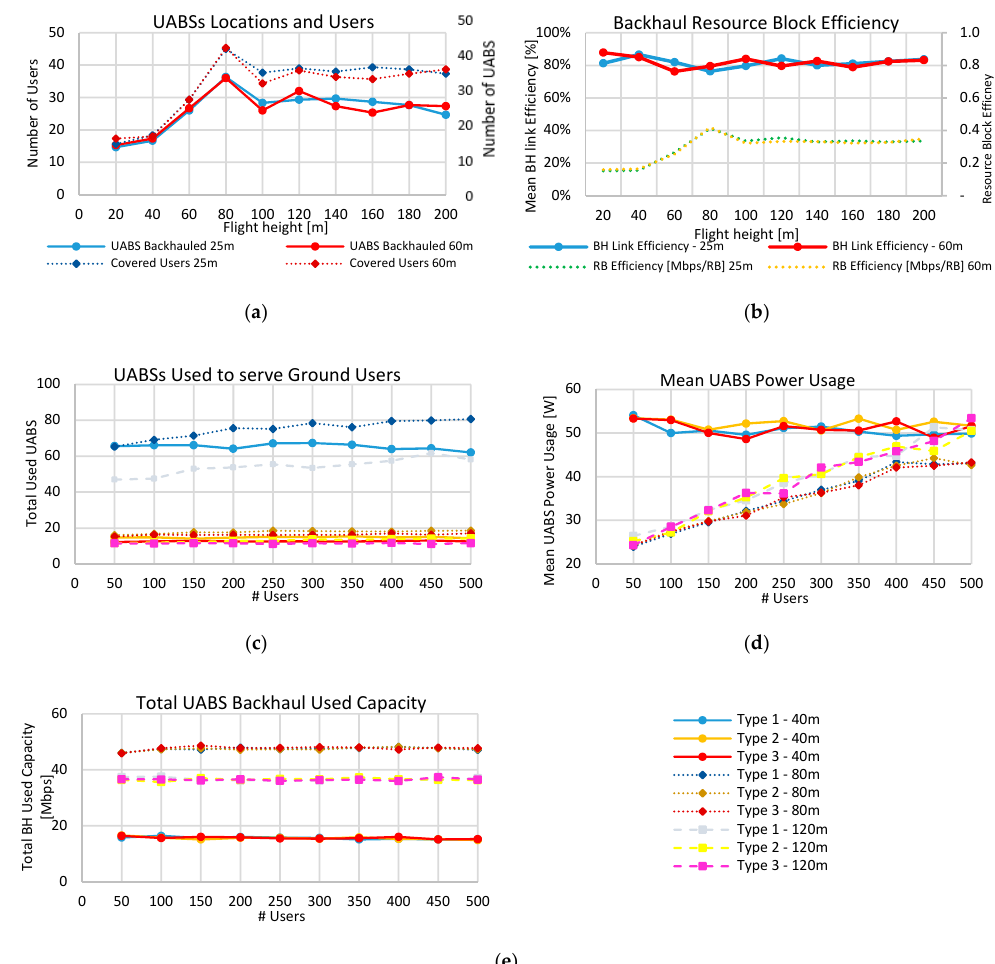
Figure 4. Evaluation results for the Scenario I. ( a ) Flight performance of UABSs. ( b ) Backhaul resource block performance. ( c ) UABS needed for different types of drones. ( d ) Power usage for different types of drones. ( e ) Backhaul network utilization for different kinds of drones.